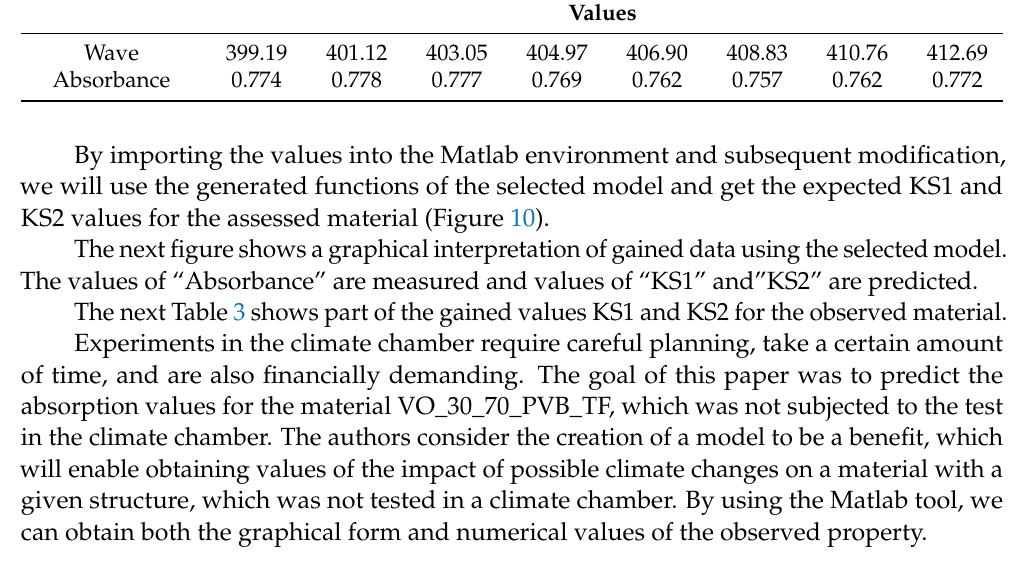
Table 2. Some of the source values by the sample absorbance.